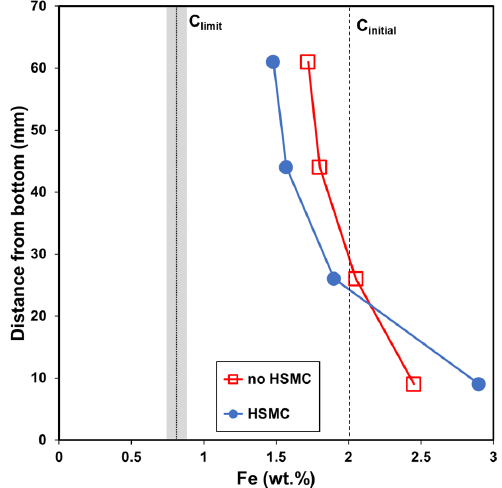
Figure 8. Effect of HSMC on the Fe level along the vertical profile for a A380-0.2Mn-2Fe alloy solidified in a preheated crucible from 700 ◦ C to room temperature and at − 0.15 K/s cooling rate. Vertical lines indicate the Fe level at the beginning of cooling (C initial ) and the expected (C limit ) after precipitation of all the